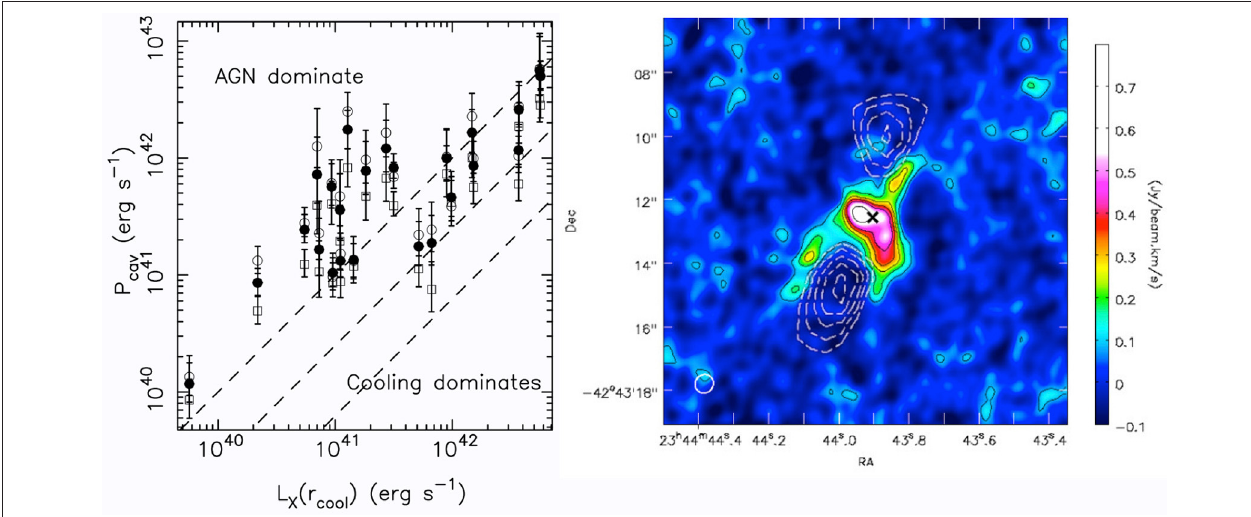
FIGURE 1 | Left: Cavity heating power (estimated as pV/t a , i.e., pressure, volume, and age, see Nulsen et al., 2009) plotted against the cooling power for objects ranging from luminous clusters, through groups, to nearby elliptical galaxies. The dashed lines represent the pV, 4 and 16 pV, from top to bottom reproduced from Nulsen et al. (2009), with the permission of AIP Publishing). Right: CO(3-2) integrated intensity map for velocities 0 to + 480km s − 1 in the Phoenix Cluster. The X-ray cavities are shown by the dashed white contours. Image taken from Russell et al. (2017), © AAS. Reproduced with